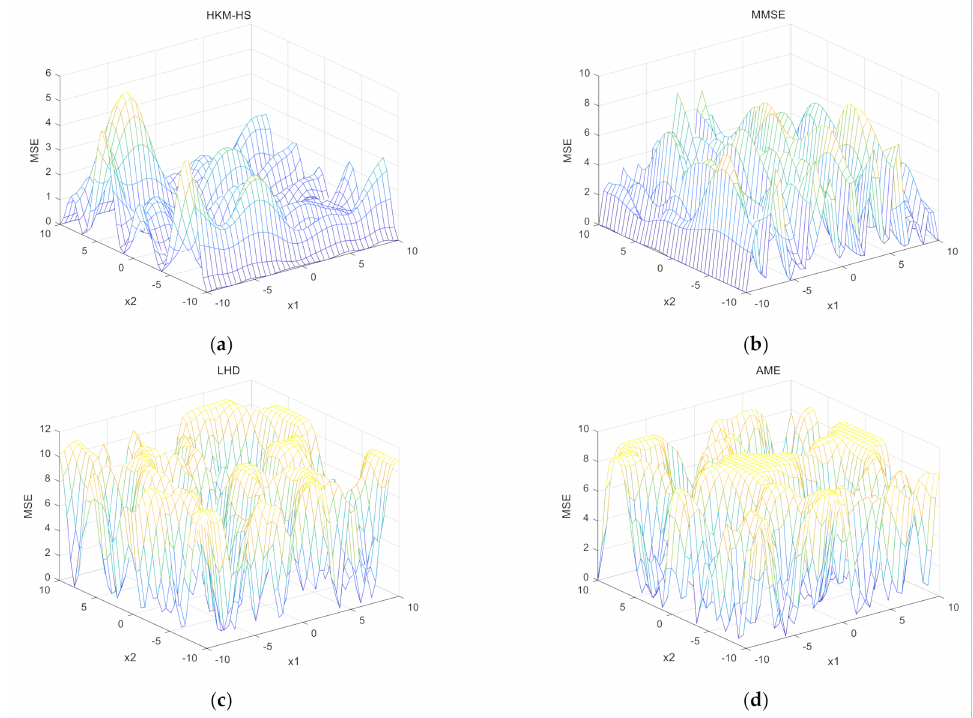
Figure 8. ( a )Test result of Alpine function by HKM-HS; ( b ) Test result of Alpine function by maximum mean square error (MMSE); ( c ) Test result of Alpine function by Latin Hypercube Design (LHD); ( d ) Test result of Alpine function by adaptive maximum entropy (AME).